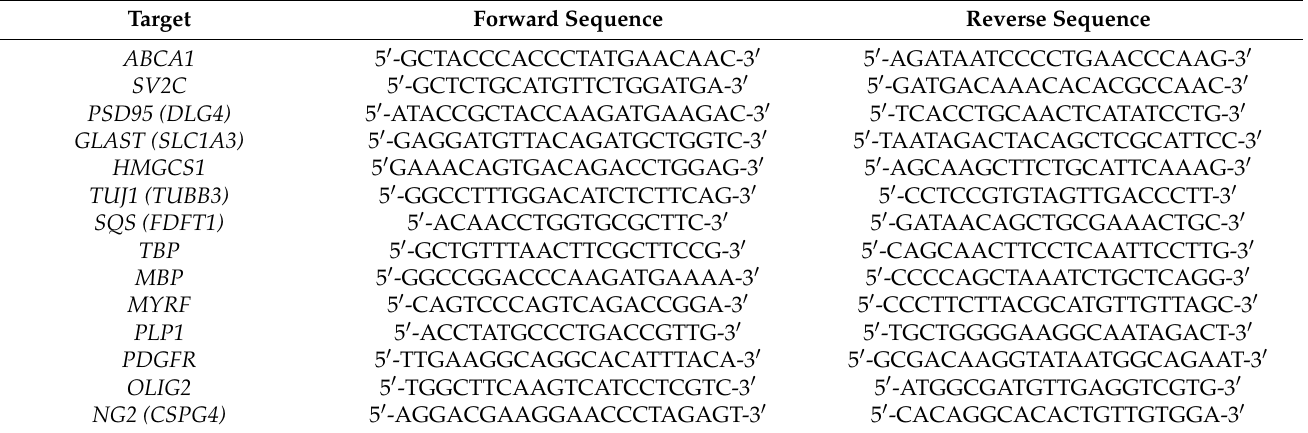
Table 1. PCR Targets and